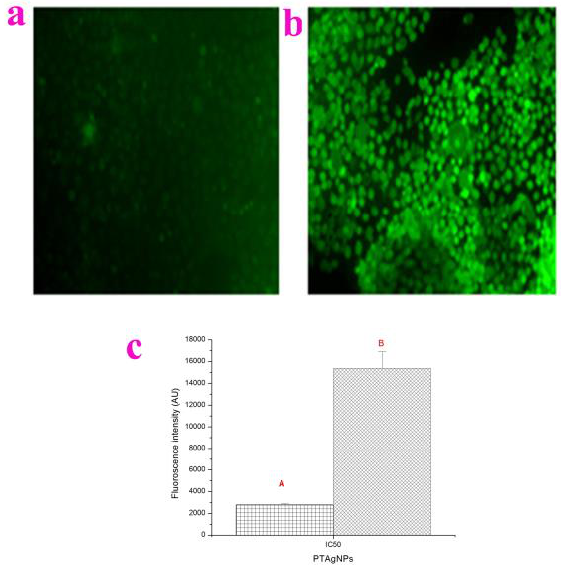
Figure 12. Fluorescent microscopic image of intracellular ROS analysis by DCFH-DA staining.( a ) Control; ( b ) treated ( c ) Spectroscopic fluorescence intensity measurement of PTAgNPs treated A431 cells compared with control. . The graphical representation indicates the production of ROS examined by a spectrofluorometer. A — Control cells, B — treated cells. Values are the mean SD from three independent replicate experiments (significantly different from the control group p < 0.05).